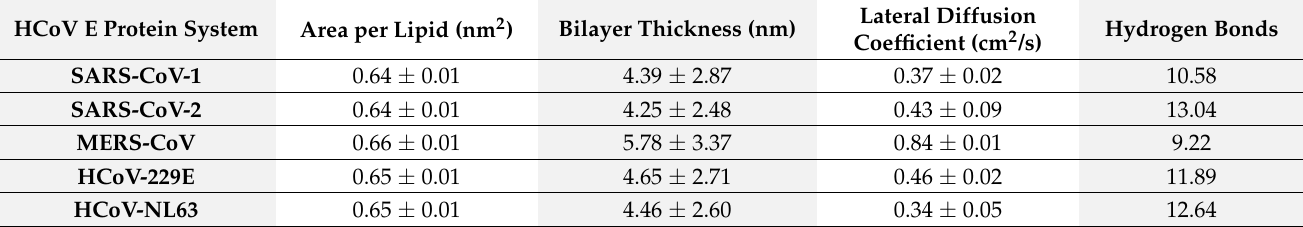
Figure 7. The area per lipid (nm 2 ) fluctuation of the simulated 1-palmitoyl-2-oleoylphosphatidy- lcholine (POPC) lipid bilayer over the 100 ns time scale for the five human (h) coronavirus (CoV) envelope (E) protein systems. Red: SARS-CoV-2 E protein, Green: SARS-CoV-1 E protein, Blue: HCoV-229E E protein, Pink: HCoV-NL63 E protein, Cyan: MERS-CoV E protein. Table 3. The lipid bilayer parameters of the 1-palmitoyl-2-oleoylphosphatidylcholine (POPC) simu- lated lipid bilayer and hydrogen bonds formed between the POPC lipids and the respective human (h) coronavirus (CoV) envelope (E) protein